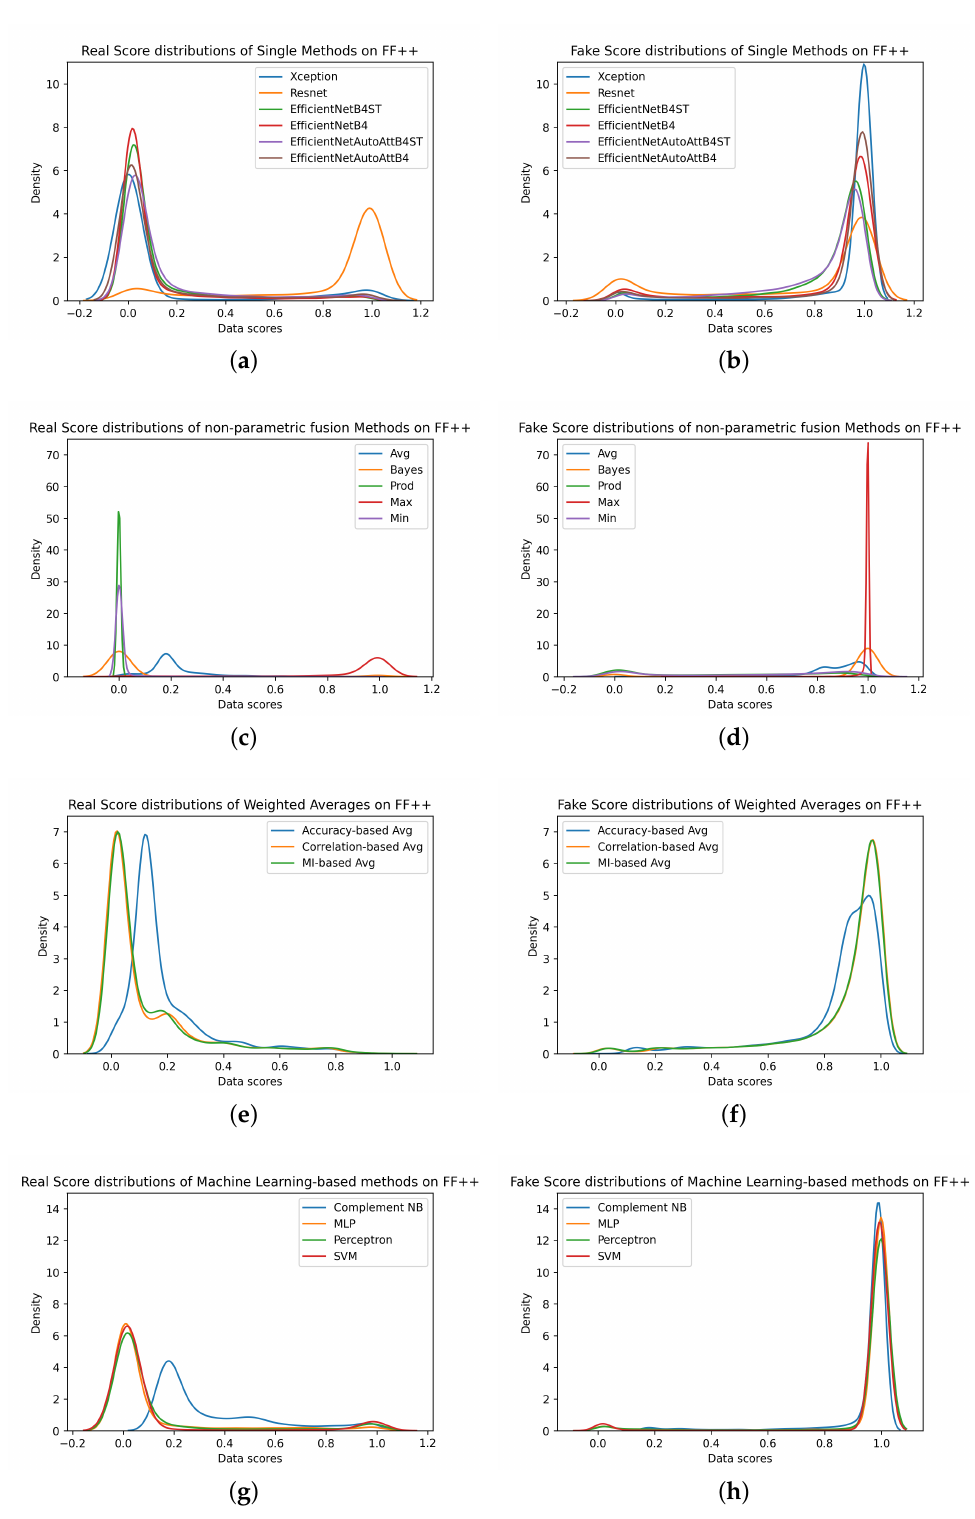
Figure 5. Real and Fake Score distributions related to the FF++ dataset from single methods ( a , b ), non- parametric fusion methods ( c , d ), weighted averages ( e , f ), and Machine Learning-based methods ( g , h